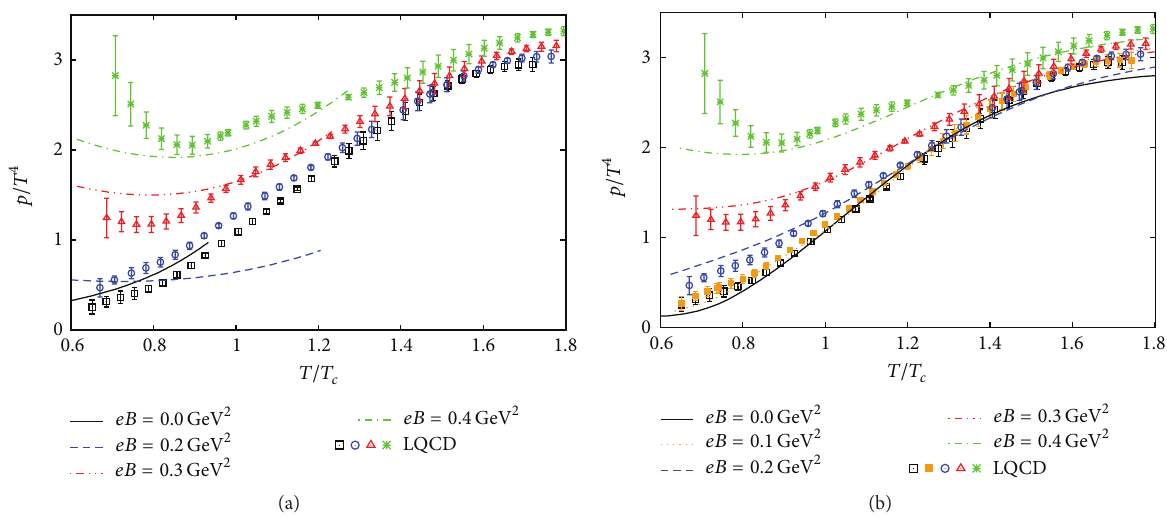
Figure 1: (a) The dependence of normalized pressure on temperature calculated from HRG model, (7) at different values of magnetic fields, 𝑒𝐵 = 0.0 , 0.1 , 0.2 , 0.3 , and 0.4 GeV 2 compared with recent lattice calculations [12] (symbols). (b) The same as in (a) but the calculations from PLSM